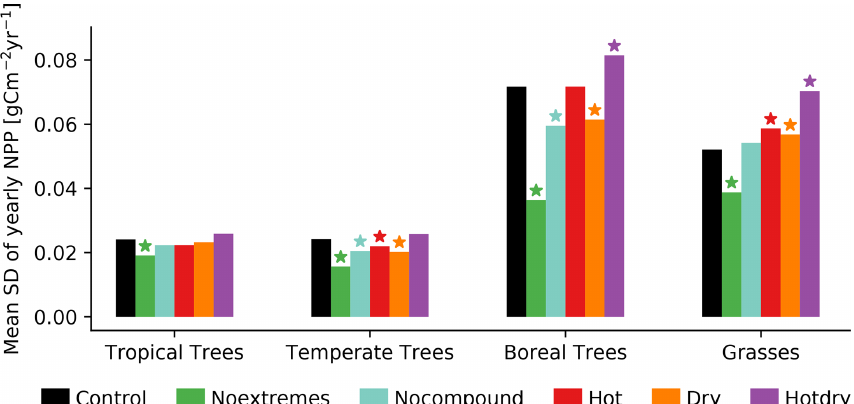
Figure 6. Variability in NPP (calculated as interannual standard deviation across years for the four vegetation classes with the mean taken over all grid cells). The stars show the scenarios that are significantly different from the Control scenario at a 5% significance level (based on a t